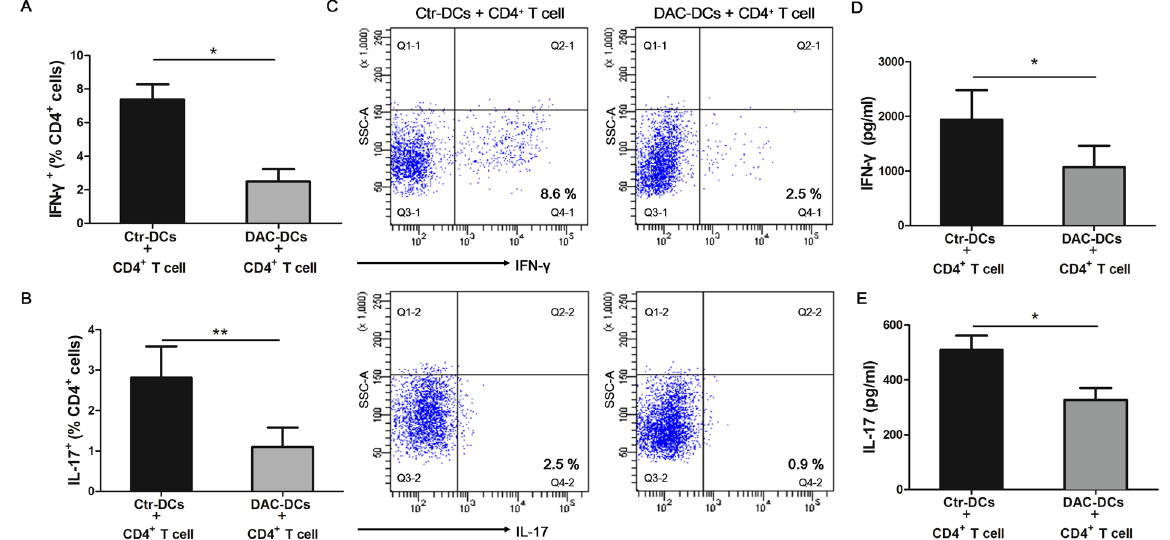
Figure 7. DAC treatment inhibits the Th1 and Th17 responses. Allogeneic CD4 + T cells (obtained from healthy controls) were co-cultured with DAC-treated or –untreated DCs (derived from VKH patients) for 5 days. The frequencies of IFN- γ + ( A ) and IL-17 + cells ( B ) in the CD4 + T cells co-cultured with DAC-treated or –untreated DCs were evaluated by flow cytometry (n = 7, * p < 0.05, ** p < 0.01). ( C ) The representative results of the IFN- γ + and IL-17 + cells in the CD4 + T cells co-cultured with DAC-treated or –untreated DCs. The protein levels of IFN- γ ( D ) and IL-17 ( E ) in the cell culture supernatants were measured by ELISA (n = 7, * p < 0.05). The data are shown as mean ± SEM. Ctr-DCs: control DCs (DAC-untreated DCs), DAC-DCs: DAC-treated DCs. Paired t test was used to compare the protein concentrations of IFN- γ and IL-17 and the frequencies of IFN- γ + and IL- 17 + cells between two